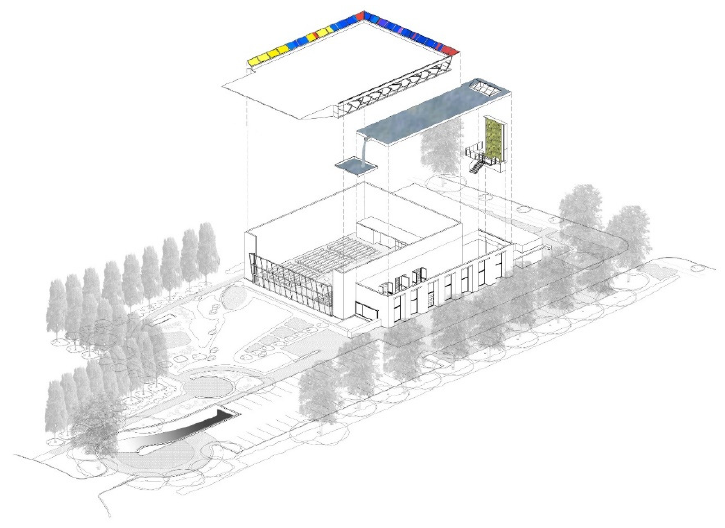
Figure 20. An exploded axonometric drawing for the final scheme that was built highlighting the major building features and its relationship to the garden. Entrance to the underground parking is located in the bottom left corner. This unprecedented decision enabled over 50% of the church site to receive soft landscaping. (Credit: Larkin Architect Limited).